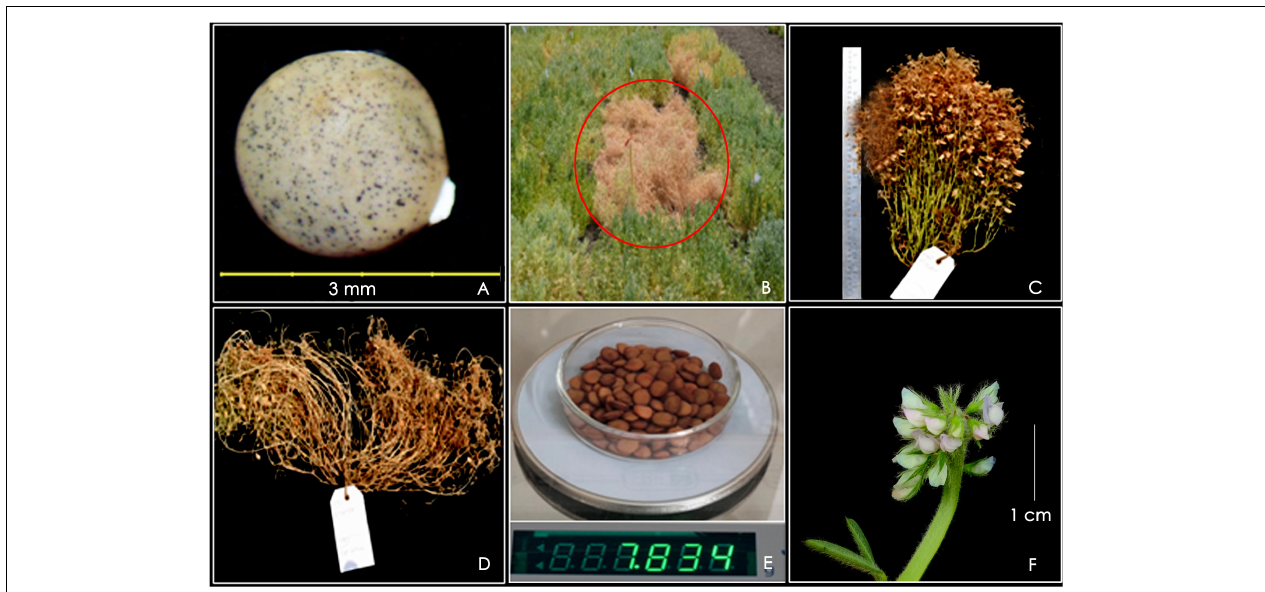
FIGURE 8 | Trait-specific lentil germplasm, (A) IC317520: unique seed morphotype with an intact funiculus; (B) IC241532: early maturing accession (circled in red) relative to surrounding germplasm; (C) EC267615: suitable to mechanical harvesting; (D) IC199461: high number of secondary branches; (E) EC499760: bold seeded type with high 100-seed weight; (F) IC241473: multiflowering